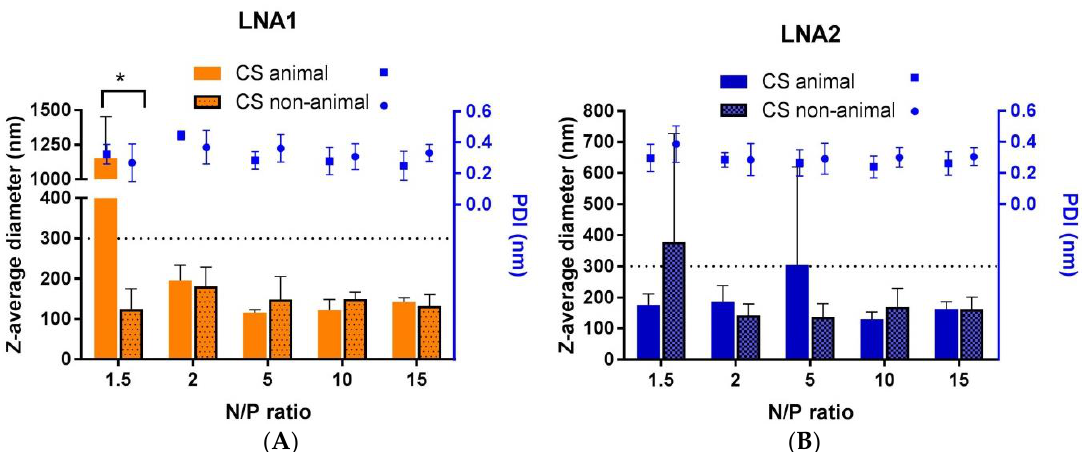
Figure 4. Variation of the Z-average size hydrodynamic diameter (nm) and polydispersity index (PDI) of chitosan (animal and non-animal) NPs formed with LNA1 ( A ) and LNA2 ( B ) at different N/P ratios (1.5, 2, 5, 10, 15). The values represented are the mean averages ± SD of three independent experiments. Statistical comparisons were done between particles formed with either animal CS or non-animal CS within the same ratio and LNA. Statistical significance (*) was determined using the Holm-Sidak method, with alpha = 5.0%.